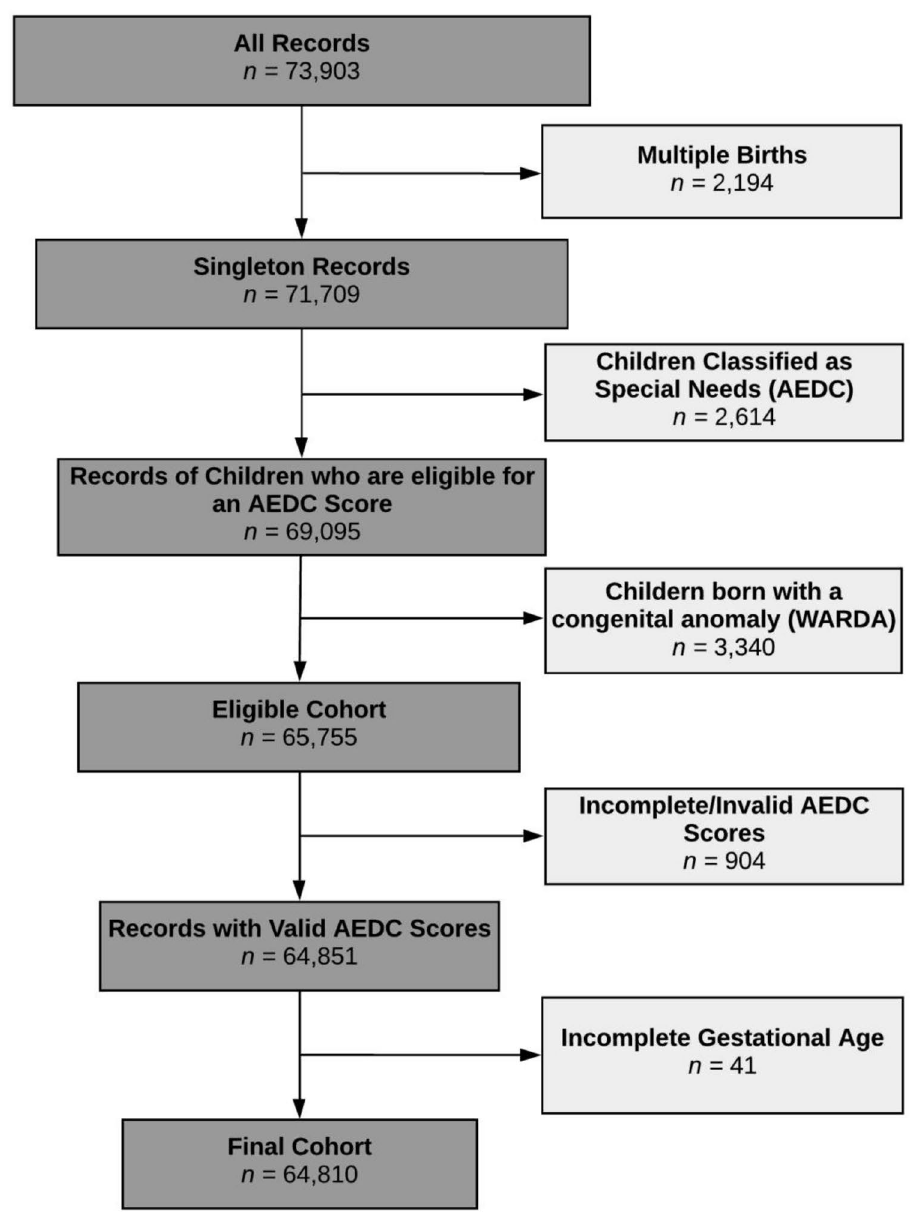
Figure 1. Eligible cohort and numbers included for analyses. AEDC Australian Early Development Census, WARDA Western Australian Register of Developmental